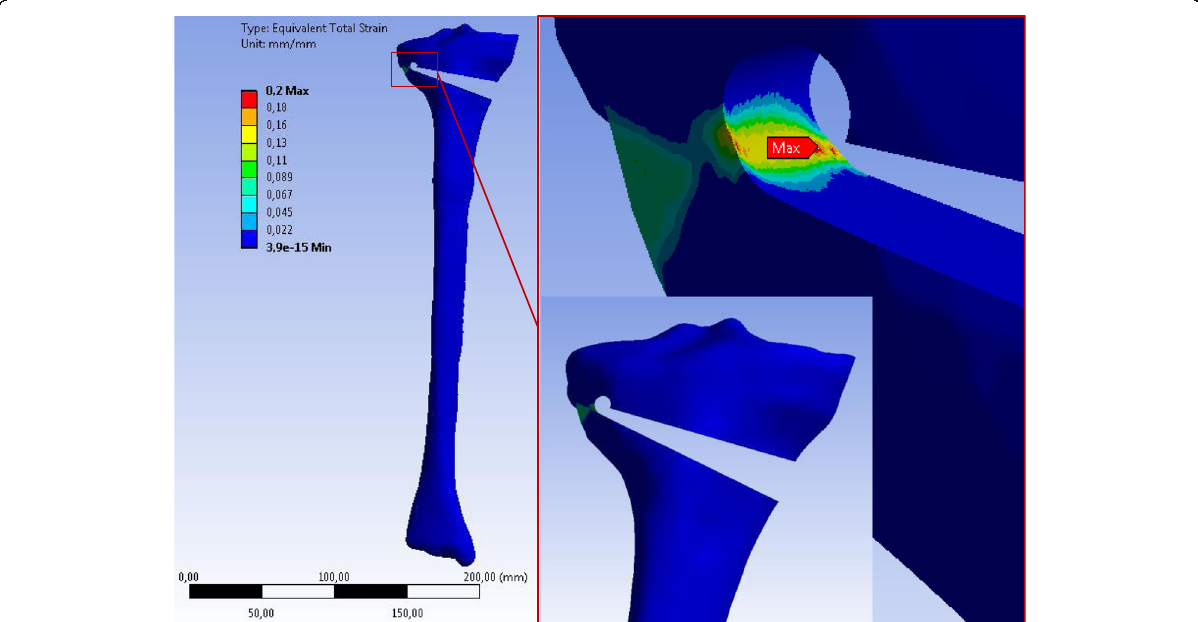
Fig. 18 Equivalent total strain (von-Mises) in the specimen SWHA for material case L: The total strain was calculated by nonlinear 3D FEA with an opening of the osteotomy gap by 10°. The specimen has been slightly rotated in the enlargement picture